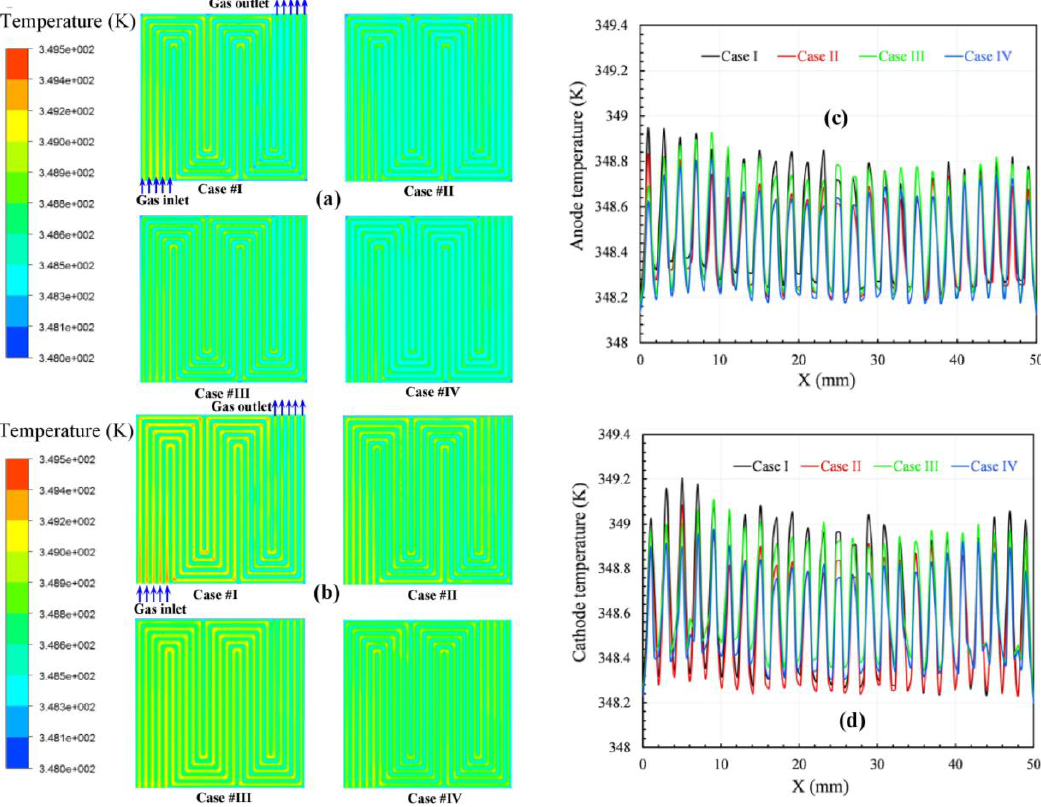
Figure 3. Comparisons of the temperatures of four simulation cases at an average current density of 1.2 A/cm 2 : ( a ) temperature distributions at the membrane’s anode side; ( b ) temperature distributions at the membrane’s cathode side; ( c ) temperature along a reference location of the anode GDL; and ( d ) temperature along a reference location of the cathode GDL.